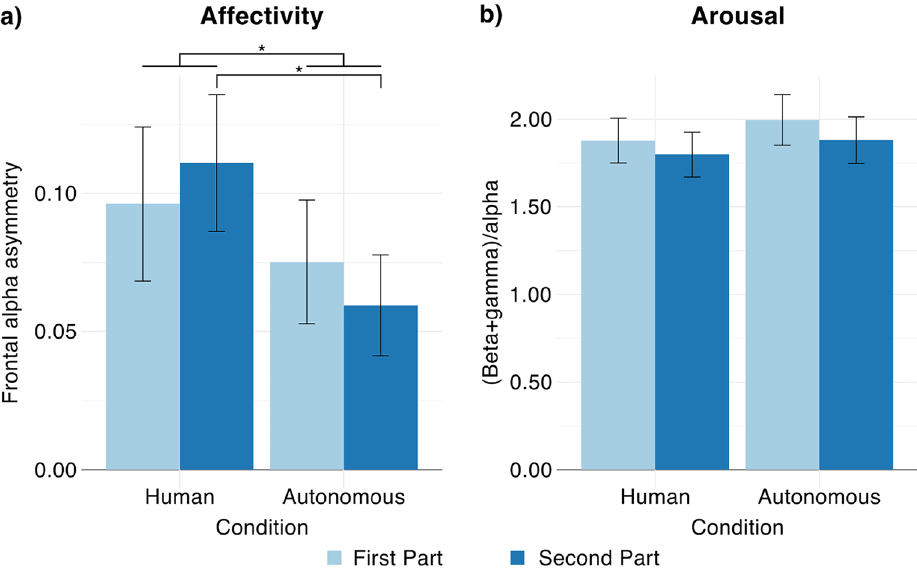
Figure 2. EEG correlates of passengers’ experience in the autonomous vehicle. Light blue bars denote the first part and dark blue bars denote the second part of the ride in the Human and Autonomous condition. Participants were characterized with frontal alpha asymmetry ( a ) and arousal ( b ) scores. Whiskers indicate the standard error of the mean; star sign denotes significant (p < 0.05)